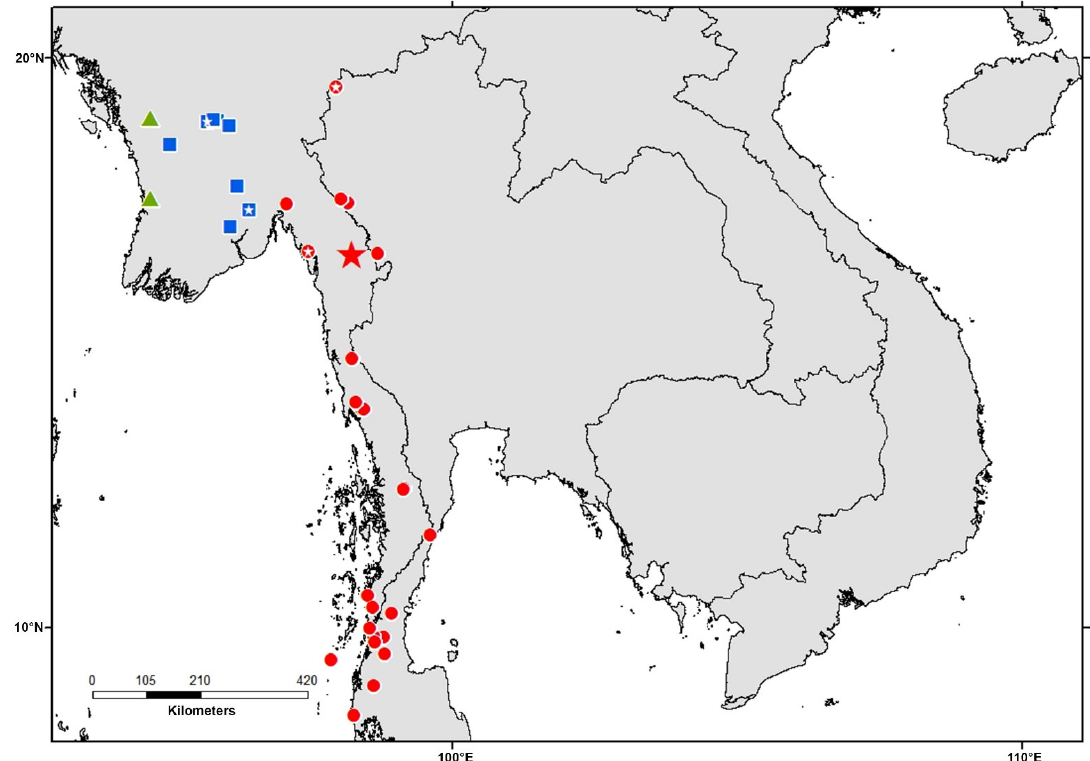
Figure 3. Map showing collecting localities of the Limnonectes species related to L. doriae included in this study Each symbol can represent one or more adjacent localities. Blue squares = Clade 1; red circles = Clade 2; green triangles = Clade 3; red star = type locality of L. doriae . Small white stars within symbols indicate localities from which bioacoustics data have been used in this study. Table 1. Mean genetic distances (in %) of Clades 1–3 (see Figure 1) of frogs referred to as Limnonectes doriae based on the 16S dataset. See text for details. Clade_3 Clade_1 Clade_3 Clade_1 2.4% Clade_2